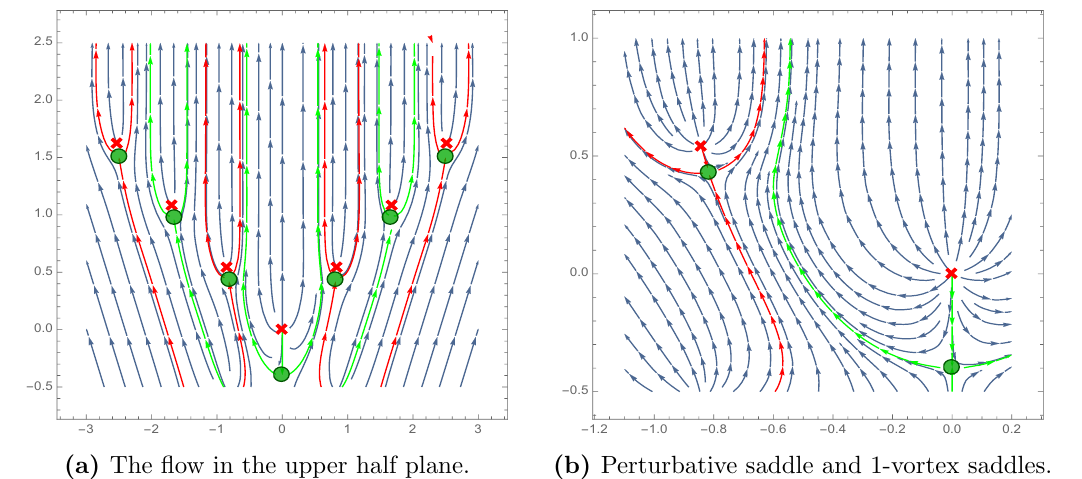
(a) The (cid:13)ow in the upper half plane. (b) Perturbative saddle and 1-vortex saddles. Figure 4. Morse (cid:13)ow for the theory with one chiral and one anti-chiral, b = e i , (cid:24) = 1. The green circles are saddles and the red crosses are poles. From each saddle the downward (cid:13)ows (the J cycles) go o(cid:11) to the sides and eventually o(cid:11) to 1 . The upward (cid:13)ows (K cycles) (cid:13)ow up to the nearest pole and they all intersect the real